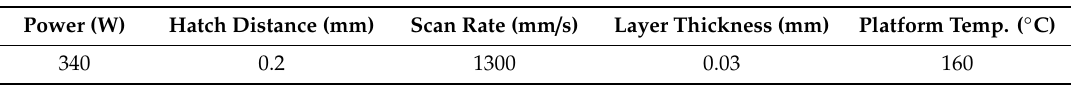
Table 1. Parameters adopted for the laser powder bed fusion (L-PBF) processing of the AlSi10Mg